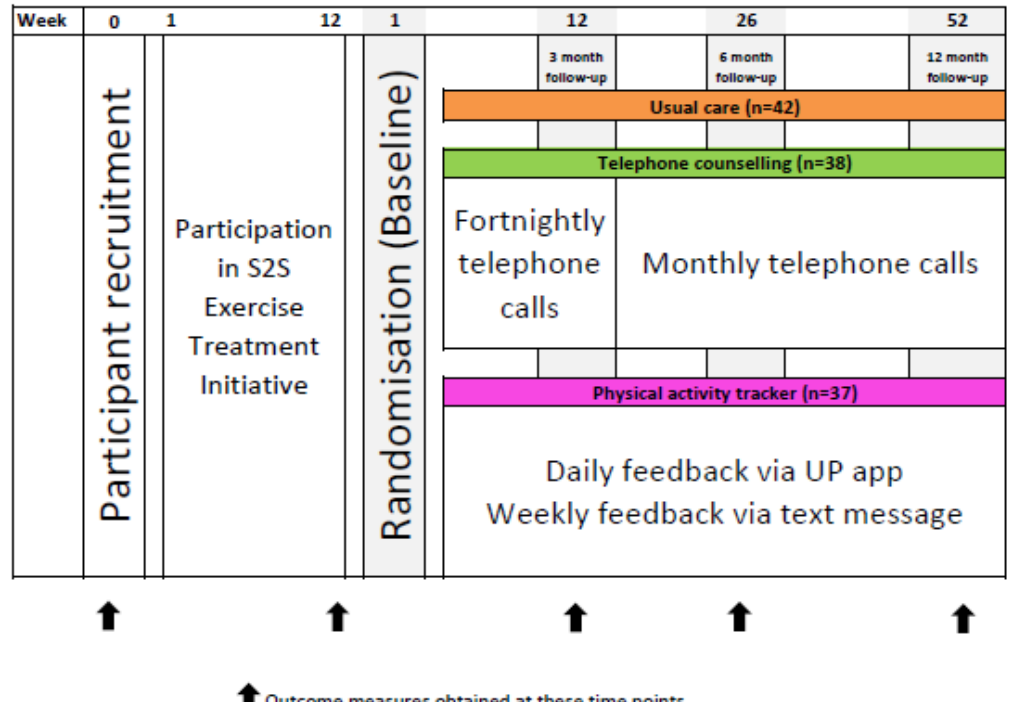
Figure 1. Study design showing time points for recruitment, randomization, and all data collection. All intervention groups included usual care. UC: usual